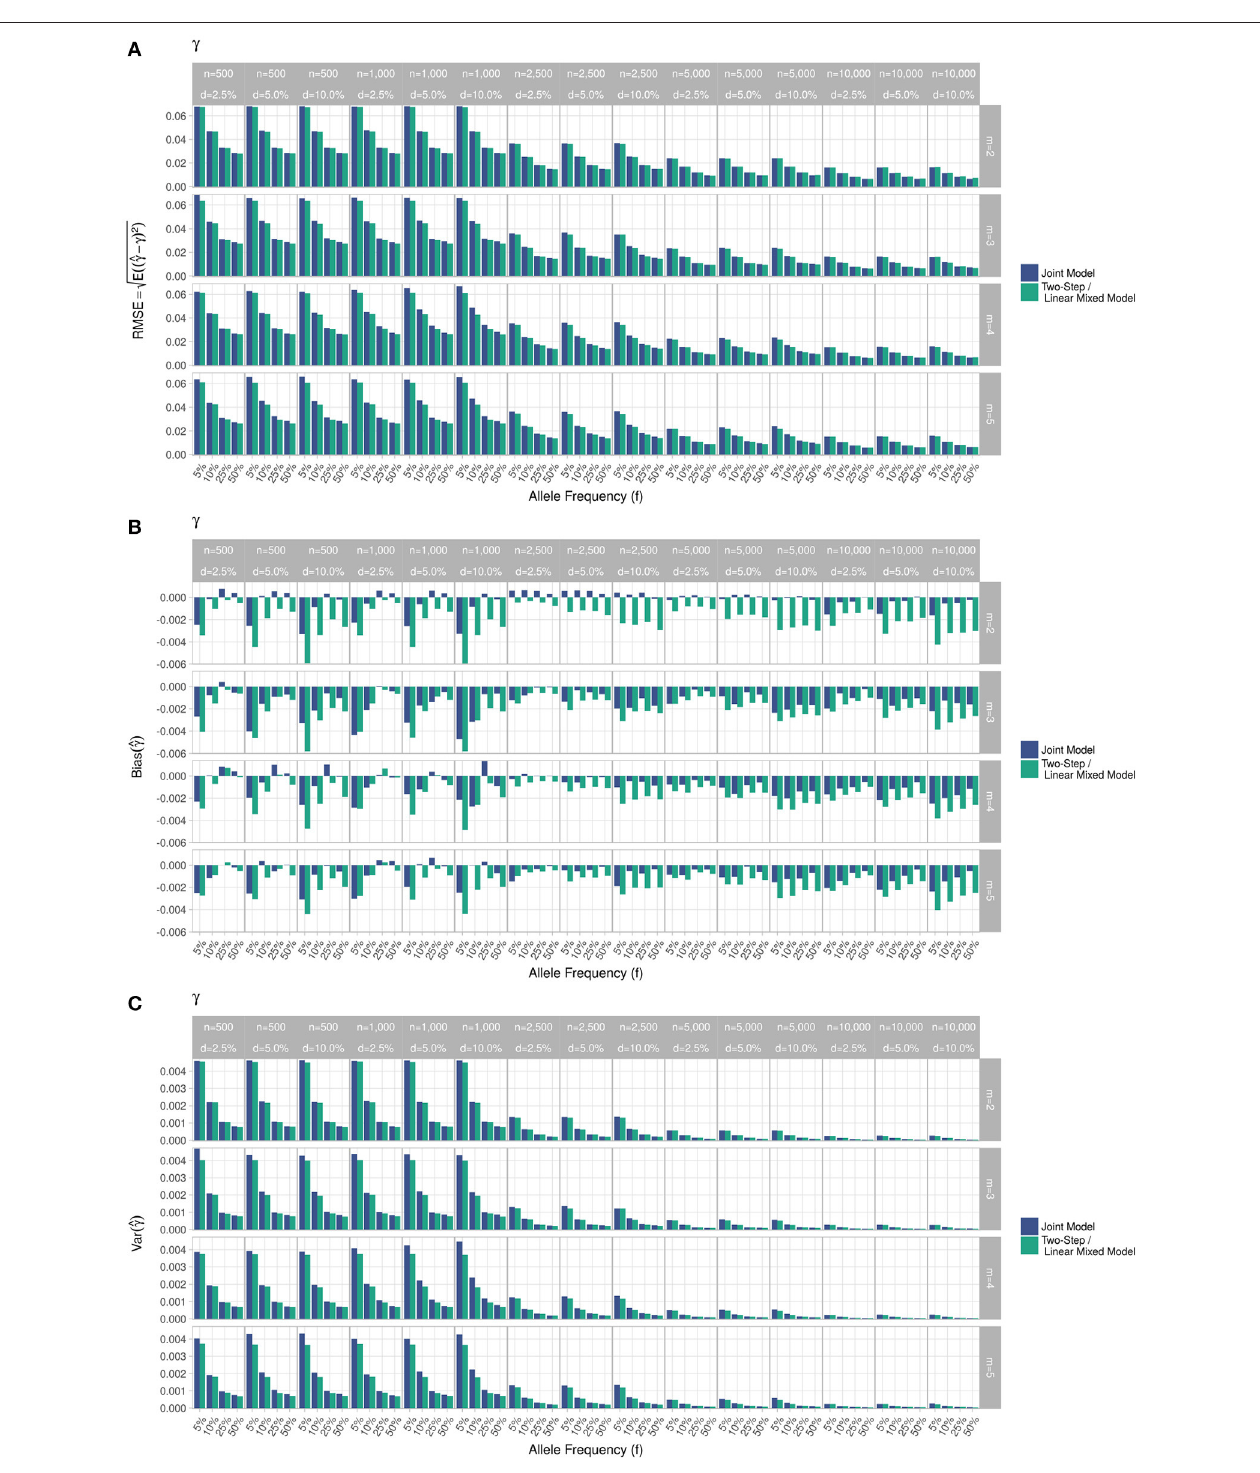
FIGURE 3 | Simulation study for accuracy of estimator ˆ γ provided by the joint model (“JM” package) and by the two-step linear mixed effect model (“nlme” package). (A) Displays RMSE, (B) Displays bias and (C) Displays variance. m , number of measures; n , number of individuals; d , diabetes incidence rate.